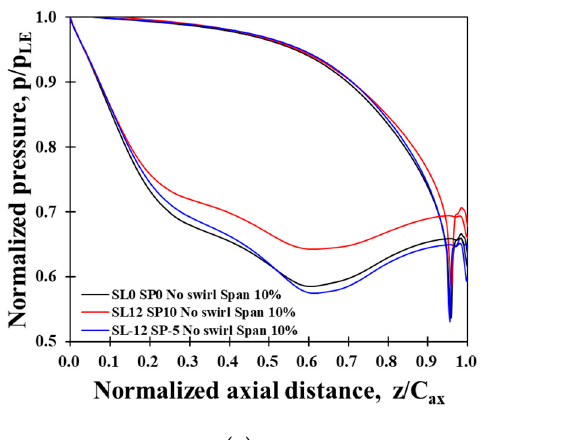
Figure 15. Comparison of NGV loading due to sweep angle: ( a ) Span height 10%; ( b ) Span height 90%.